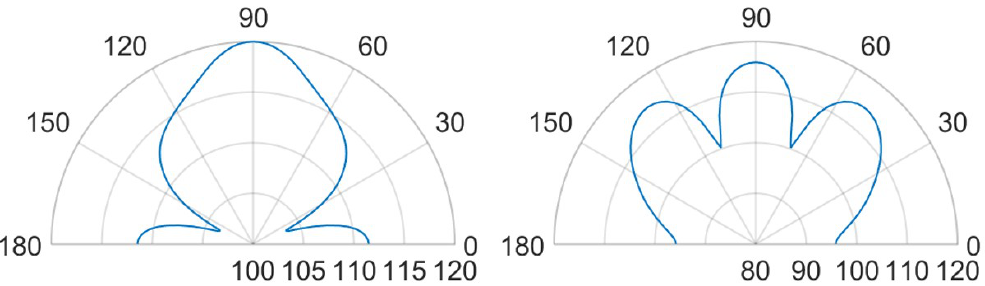
Figure 25. SPL polar plot (dB) at the performing fundamental frequency of 85.5 kHz (10 V bias), at 3.5 cm in the y(90 ◦ )–z(0 ◦ ) plane: (d) ( left ), (e) ( right ).